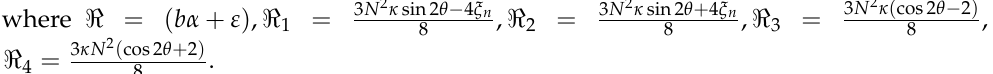
Figure 5. ( a ) Δ 1 vs. μ and b n for different m 2 ; ( b ) Δ 1 vs. b n for different μ ( m 2 = 0.3, c s = 0.003, c n = 0.002); ( c ) Δ 1 vs. μ for different b n ( m 2 = 0.3, c s = 0.003, c n = 0.002).